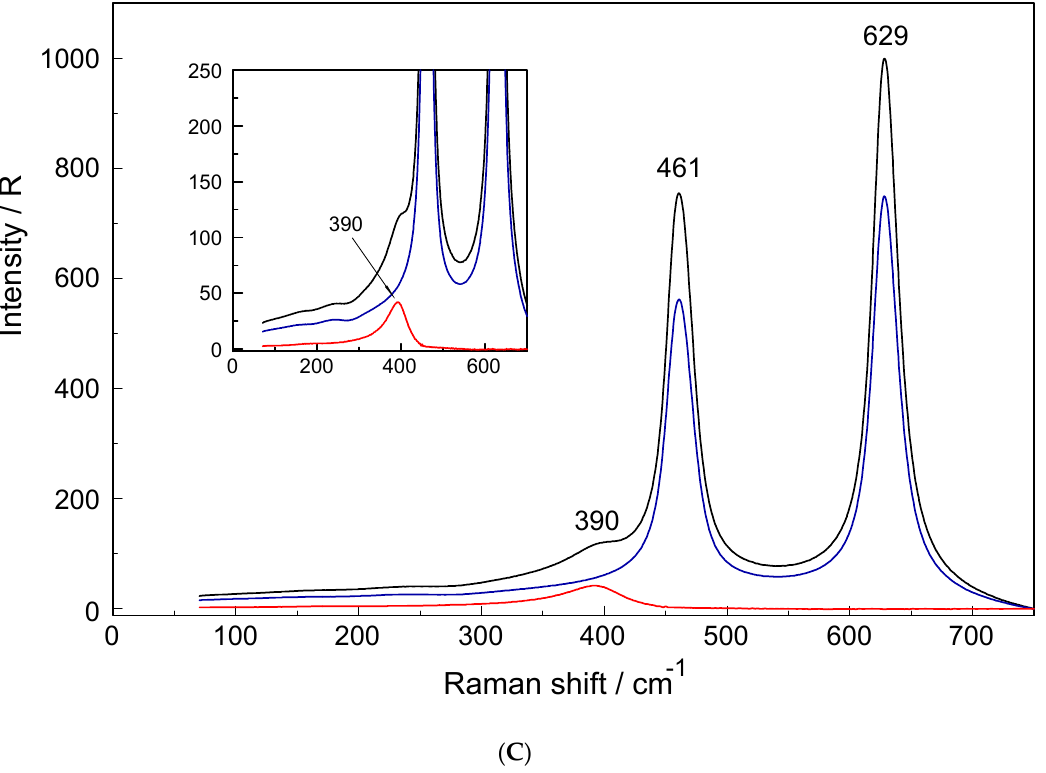
Figure 1. A. Raman scattering profiles in R-format (from top to bottom: R VV (black), R VH (blue) and R iso (red)) of a 3.801 mol·L − 1 NaClO 4 (aq) solution (R W = 12.05). Note the broad weak mode at 166 cm − 1 is due to the restricted translation of the O-H···H unit of the water molecules. The much larger, depolarized modes at 461 cm − 1 and 629 cm − 1 are the deformation modes of perchlorate, ClO 4 − (aq). B. A Yb(ClO 4 ) 3 solution spectrum at 0.240 mol·L − 1 (R w = 226.6) in R-format (spectra from top to bottom: R VV (black), R VH (blue) and R iso (red)). The inset shows the R iso spectrum in greater detail. Note the broad and weak ν 1 YbO 8 stretching mode at 394 cm − 1 (fwhh = 52 cm − 1 ) of the [Yb(OH 2 ) 8 ] 3+ species. The much larger, depolarized bands at 461 cm − 1 and 629 cm − 1 are the deformation modes of perchlorate, ClO 4 − (aq). C. Raman scattering profiles of a Yb(ClO 4 ) 3 solution at 2.423 mol·L − 1 in R-format (spectra from top to bottom: R VV (black), R VH (blue) and R iso (red)). The inset shows the R iso spectrum in greater detail. Note the broad and weak ν 1 YbO 8 stretching mode at 390 cm − 1 of the [Yb(OH 2 ) 8 ] 3+ species. The much larger, depolarized bands at 461 cm − 1 and 629 cm − 1 are the deformation modes of perchlorate, ClO 4- (aq).